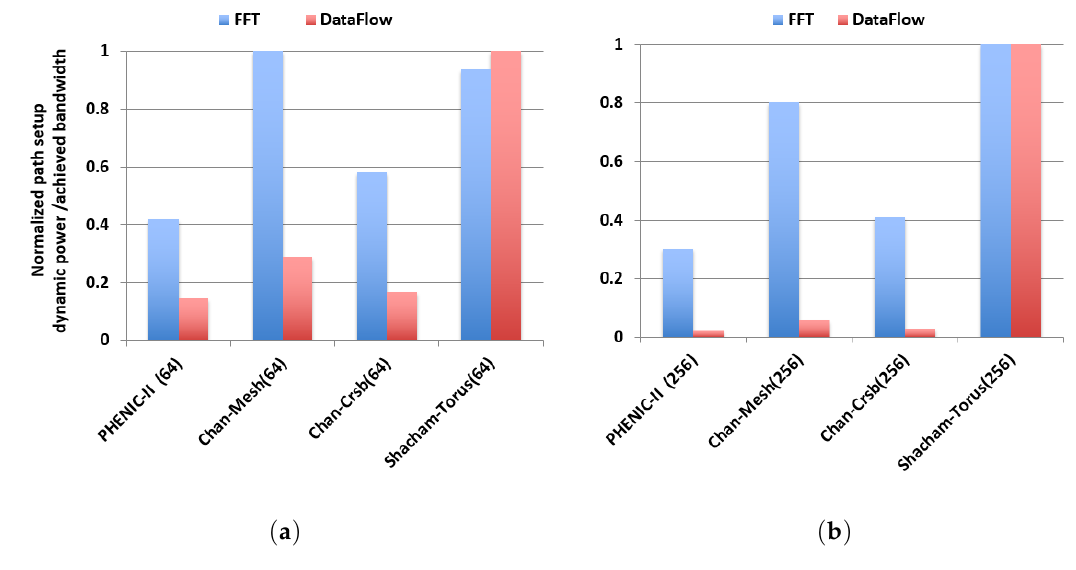
Figure 17. Normalized path setup dynamic power per achieved bandwidth: ( a ) 64 cores; ( b ) 256 cores.